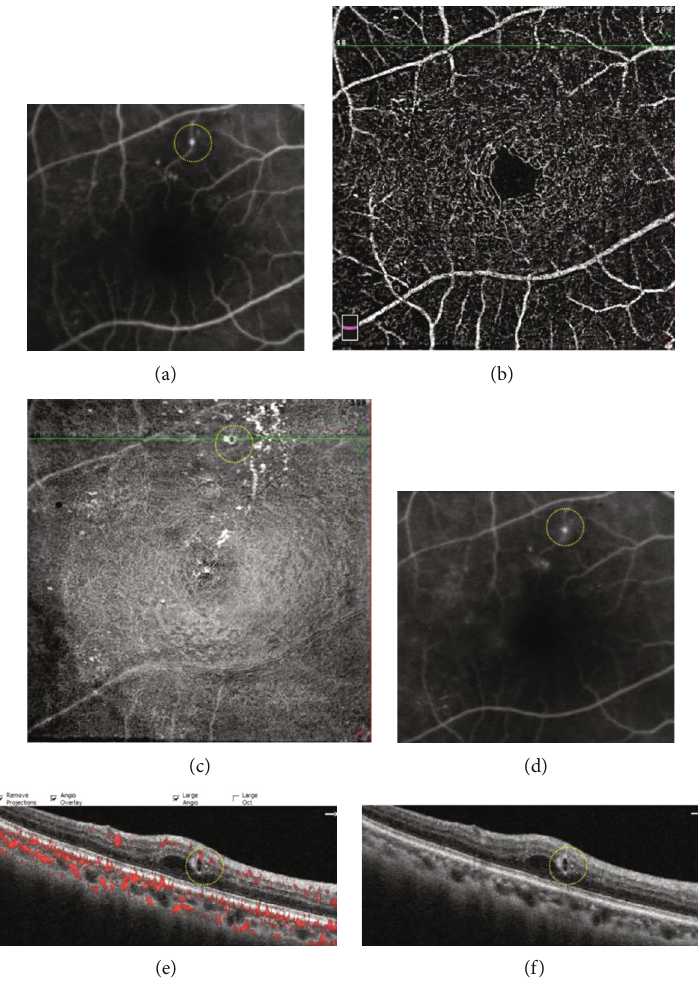
Figure 2: A typical diabetic microaneurysm with no leakage seen by FA (yellow circle (a), early phase of FA (d), late phase of FA). The microaneurysm was not visualized in OCTA en face image (b). On OCT en face image, the microaneurysm appeared as luminescent ring-shaped morphology (c). The microaneurysm was recognized as an oval well-demarcated lesion on OCT B-scan (f), and the lumen was devoid of fl ow signal on OCT B-scan with fl ow overlay